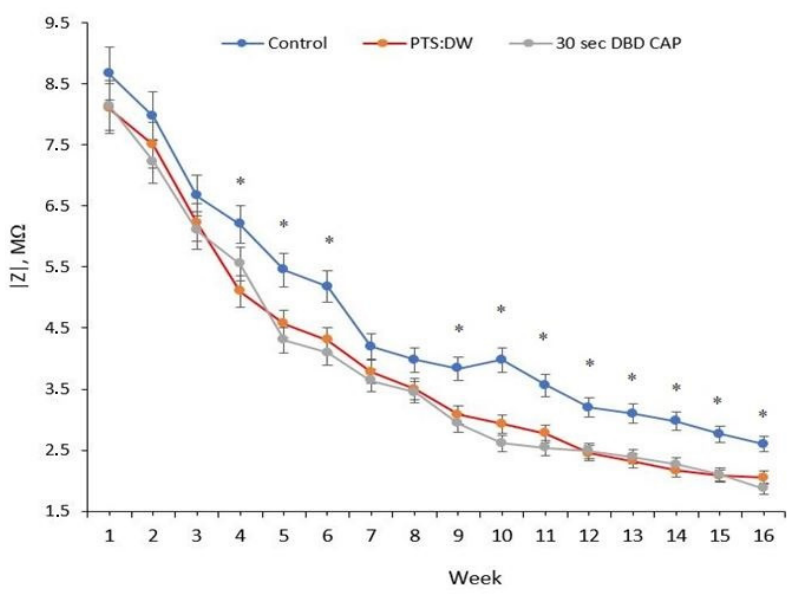
Figure 9. Changes in the impedance modulus of the grafting zone after subtracting the parasitic capacitance of the electrodes (4 months after grafting). All data are mean ± SD from triple repetitions. Statistically significant differences ( p < 0.05) relative to control were calculated with Student’s t-test and are marked with an asterisk (*).